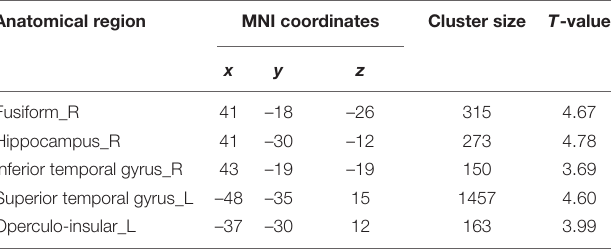
TABLE 2 | Brain regions displaying significant differences in GMV between patients with CTN and HC